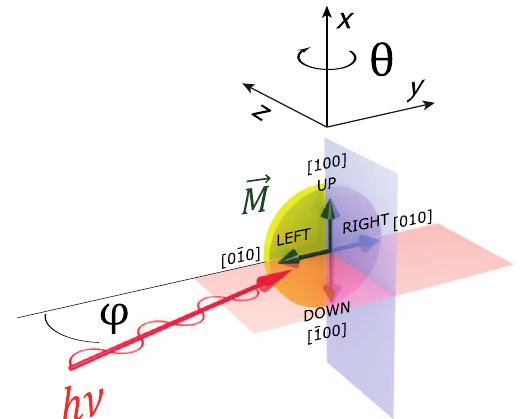
FIG. 1. Schematic representation of the experimental ARPES geometry. Light incidence and electron emission planes are indicated by a red (horizontal) and a blue (vertical) plane, respectively. Black arrows represent magnetization directions referred to as UP, DOWN, LEFT, and